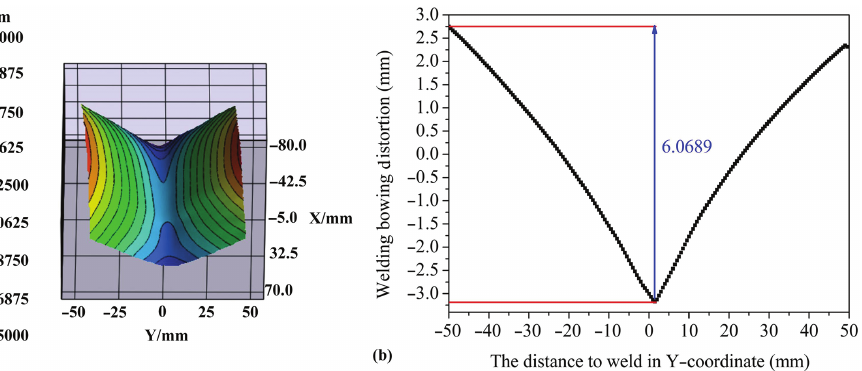
Figure 3: Match procured between the reference and deformation images: (a) reference image, (b) deformation image, (c) and (d) are the mag- nified points on (a) and (b), respectively.